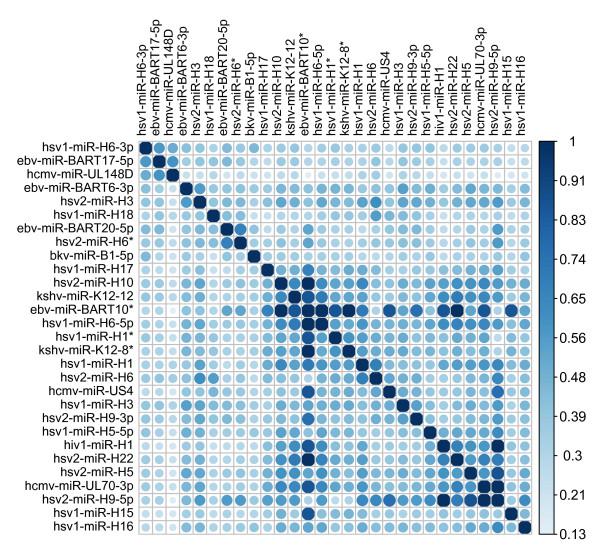
Functional similarity matrix of viral miRNAs.